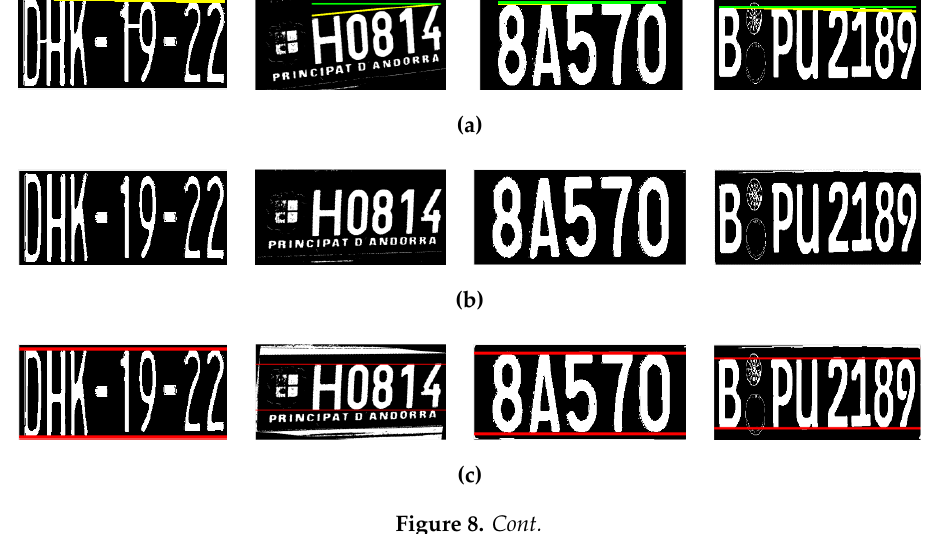
Figure 7. FG polarity uniformity and region of interest (ROI) extraction process: (a) original LP images, (b) gray images, (c) thresholded images, (d) extracted ROI having the same foreground polarity.